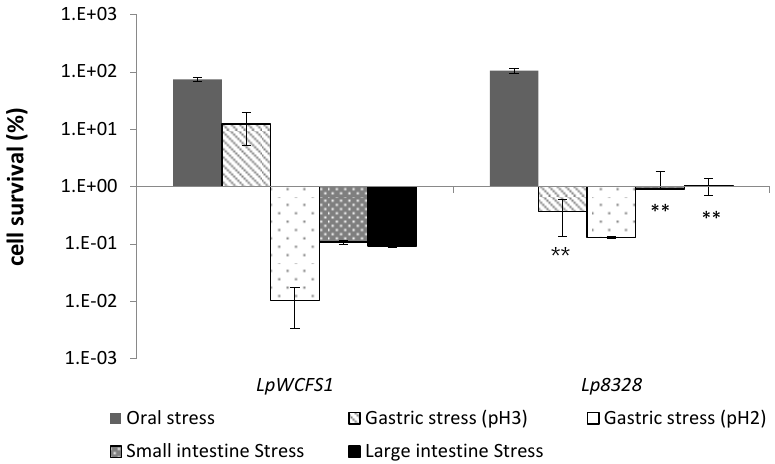
Figure 3. Bacterial survival after exposure of L. plantarum strains inoculated in yogurt to an in vitro model simulating the human oro-gastrointestinal tract (oral, gastric pH 3.0 and pH 2.0 and small and large intestine stresses). Viability was calculated as the percent of survival relative to the untreated control ( i.e ., the sample before the simulated digestion). Values represent the mean ± the standard deviation of three different experiments. Statistical analyses were carried out by the Student’s t -test, and significant differences are relative to the probiotic L. plantarum WCFS1 strain (* p < 0.05 and ** p < 0.005). LpWCFS1, L. plantarum WCFS1; Lp8328, L. plantarum CECT